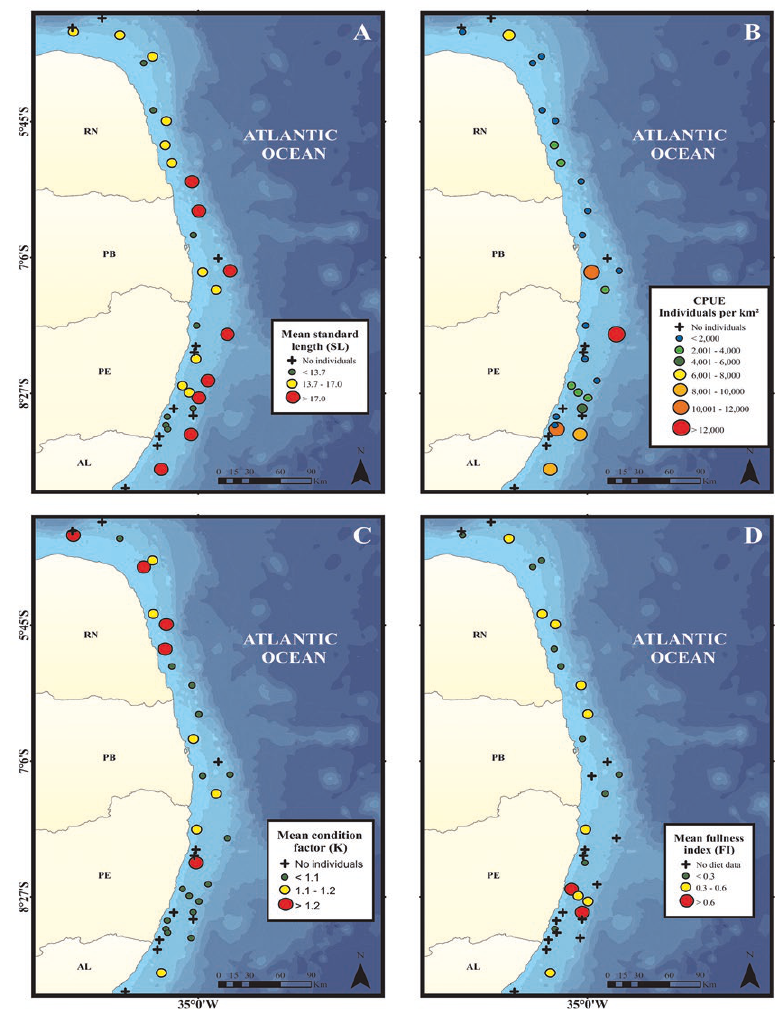
Fig. 4. – Spatial representation of mean standard length (A), catch per unit effort (B), mean condition factor (C) and mean fullness index (D) of P. maculatus distributed along the sampling points on the continental shelf of northeast